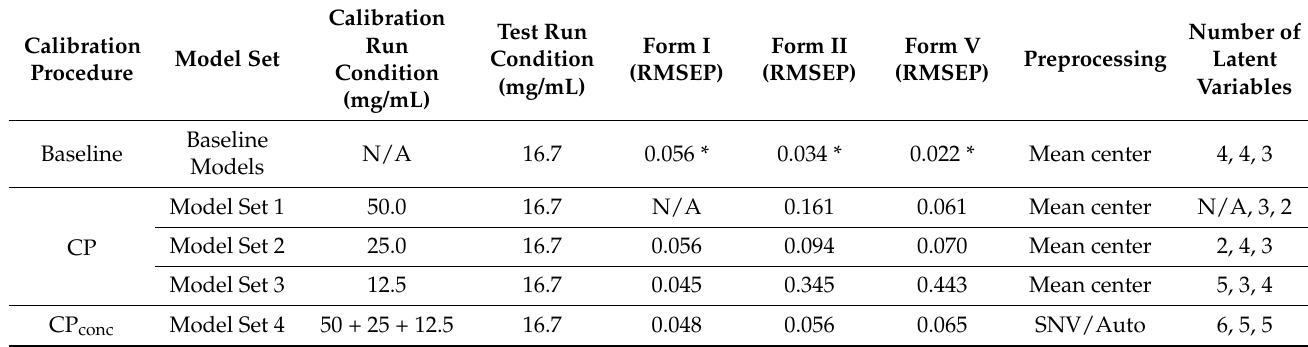
Table 4. Prediction performance of each model generated for the HCl salt experiments. Note that the % relative standard deviation of Raman quantitation was approximately 1.12%, and all models had R 2 >